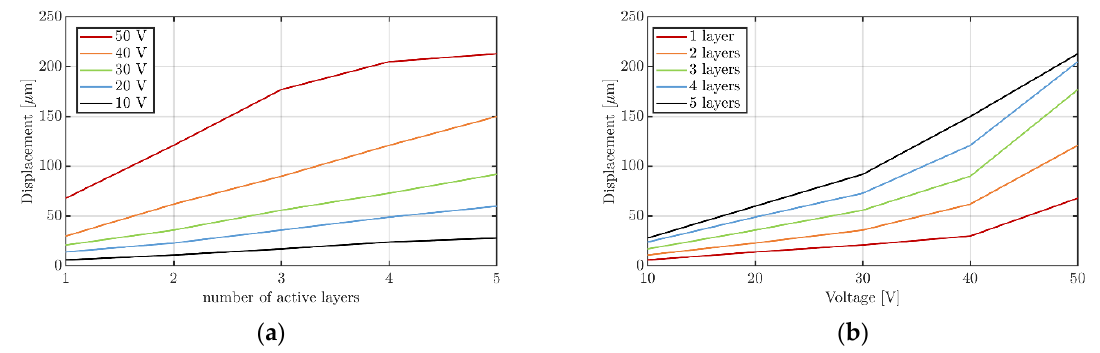
Figure 6. Resulting out-of-plane displacements in dependency of: ( a ) the number of active layers and; ( b ) the applied voltage.